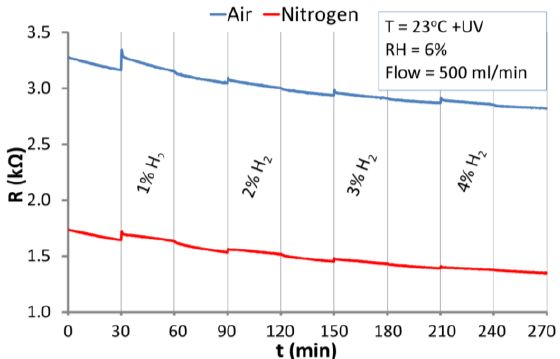
Figure 11. Response of the ZnO nanostructures to H 2 and at UV irradiation under atmospheres of air and nitrogen at RT.